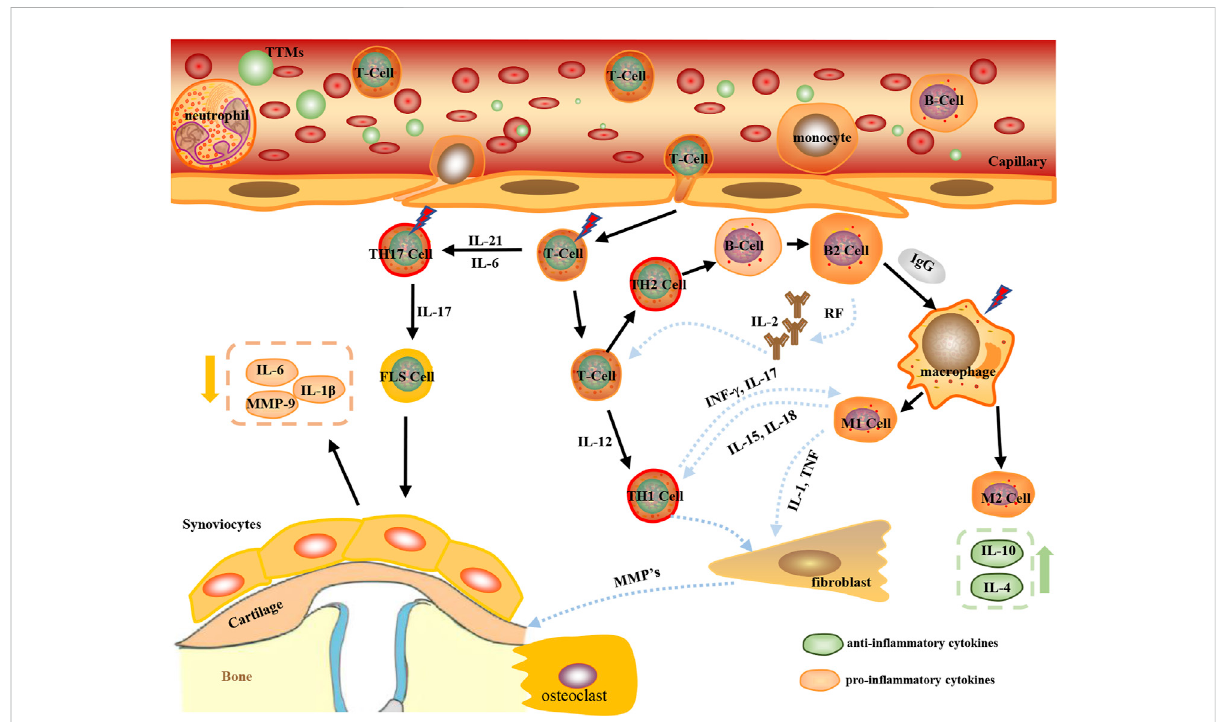
FIGURE 4 Anti-RA mechanism classi fi cation of main TTM active components by immunoregulation.